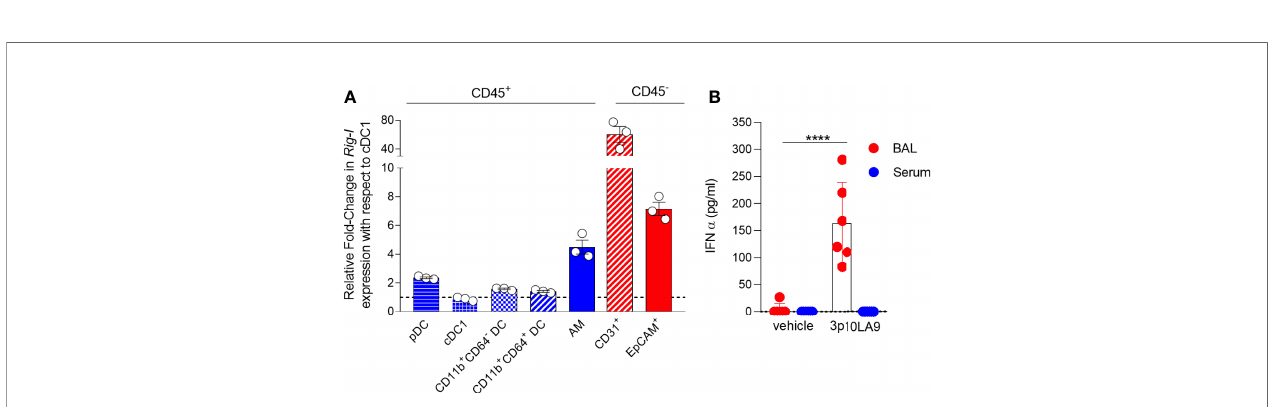
FIGURE 2 | Intranal delivered dsRNA hairpin mediates IFN- a response in the lungs. (A) Quantitative PCR (qPCR) analysis of RIG-I expression in sorted lung AM, pDCs, CD103 + DCs, CD11b + CD64 - DCs, and CD11b + CD64 + DCs as well as EpCAM + epithelial cells and CD31 + endothelial cells. (B) IFN- a BAL and serum levels were measured by sandwich ELISA 14 h after intranasal delivery (control: vehicle alone; treated group: 3p10LA9). The error bars represent the SD (n= 6 mice).;**** P <0.0001; two-tailed t-Student ’ s Test.